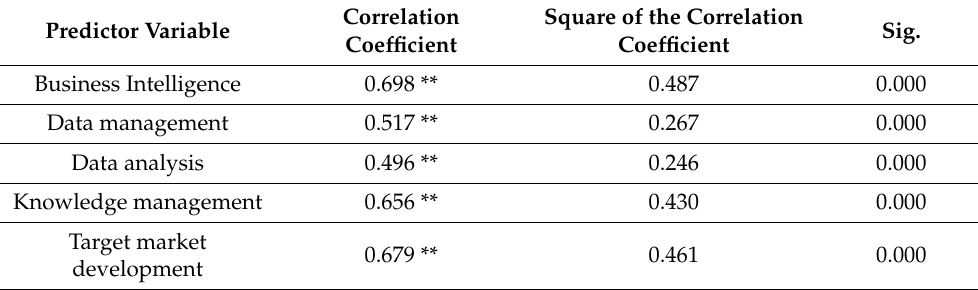
Table 8. Coefficient of correlation between applying business intelligence and its dimensions and brand internationalization in large industrial firms.